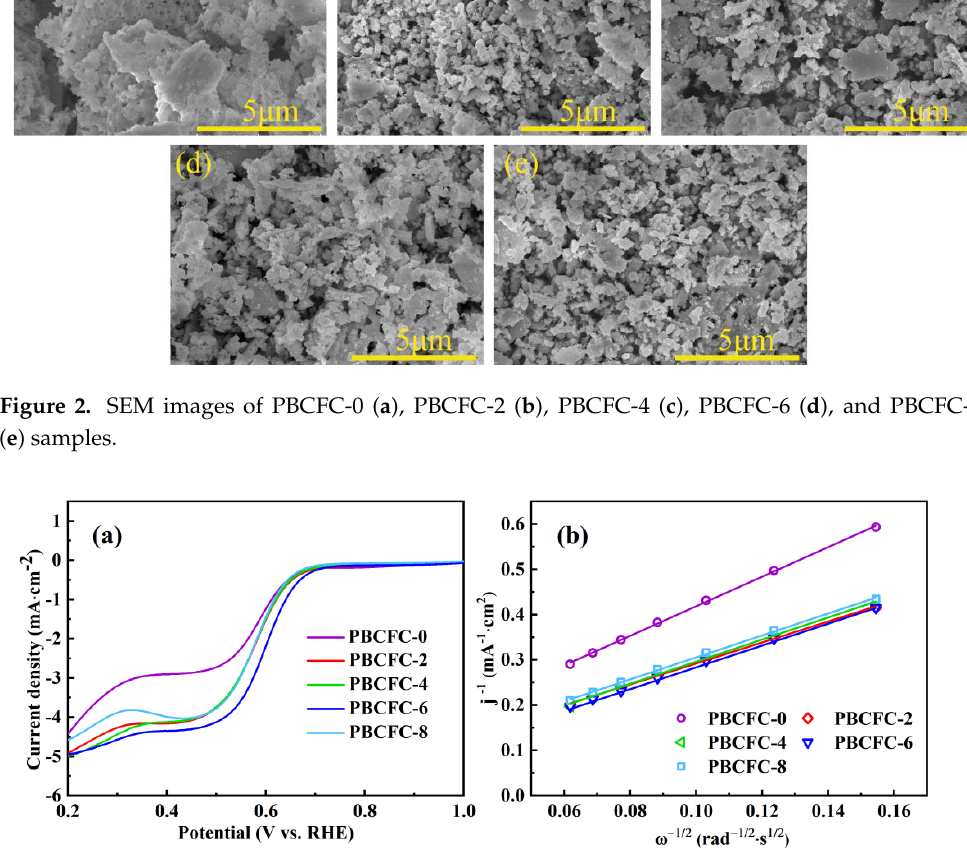
Figure 3. ORR polarization curves of PBCFC-x (x = 0, 2, 4, 6, 8) at 1600 rpm ( a ); The value of electrons transferred for PBCFC-x (x = 0, 2, 4, 6, 8) at 0.4 V vs. RHE ( b ). transferred for PBCFC-x (x = 0, 2, 4, 6, 8) at 0.4 V vs. RHE ( b